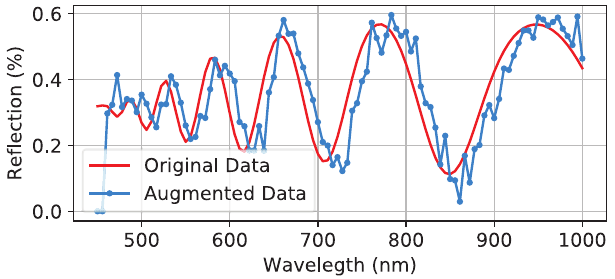
Fig. 4. Example of data augmentation.